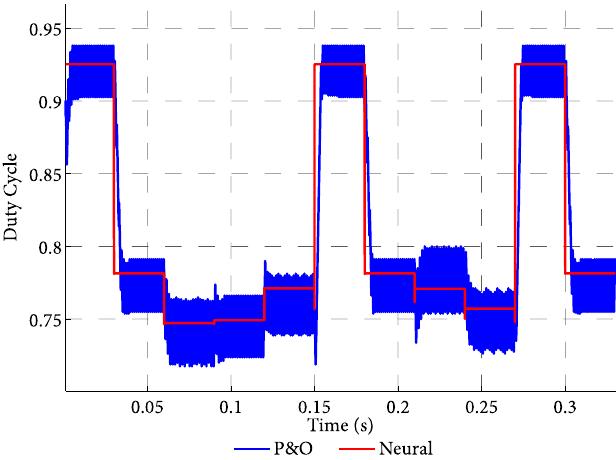
Figure 22. Duty cycle under variable irradiation.